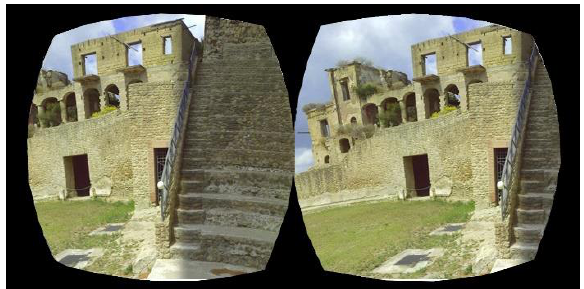
Figure 14: Visualization of the virtual tour through a VR